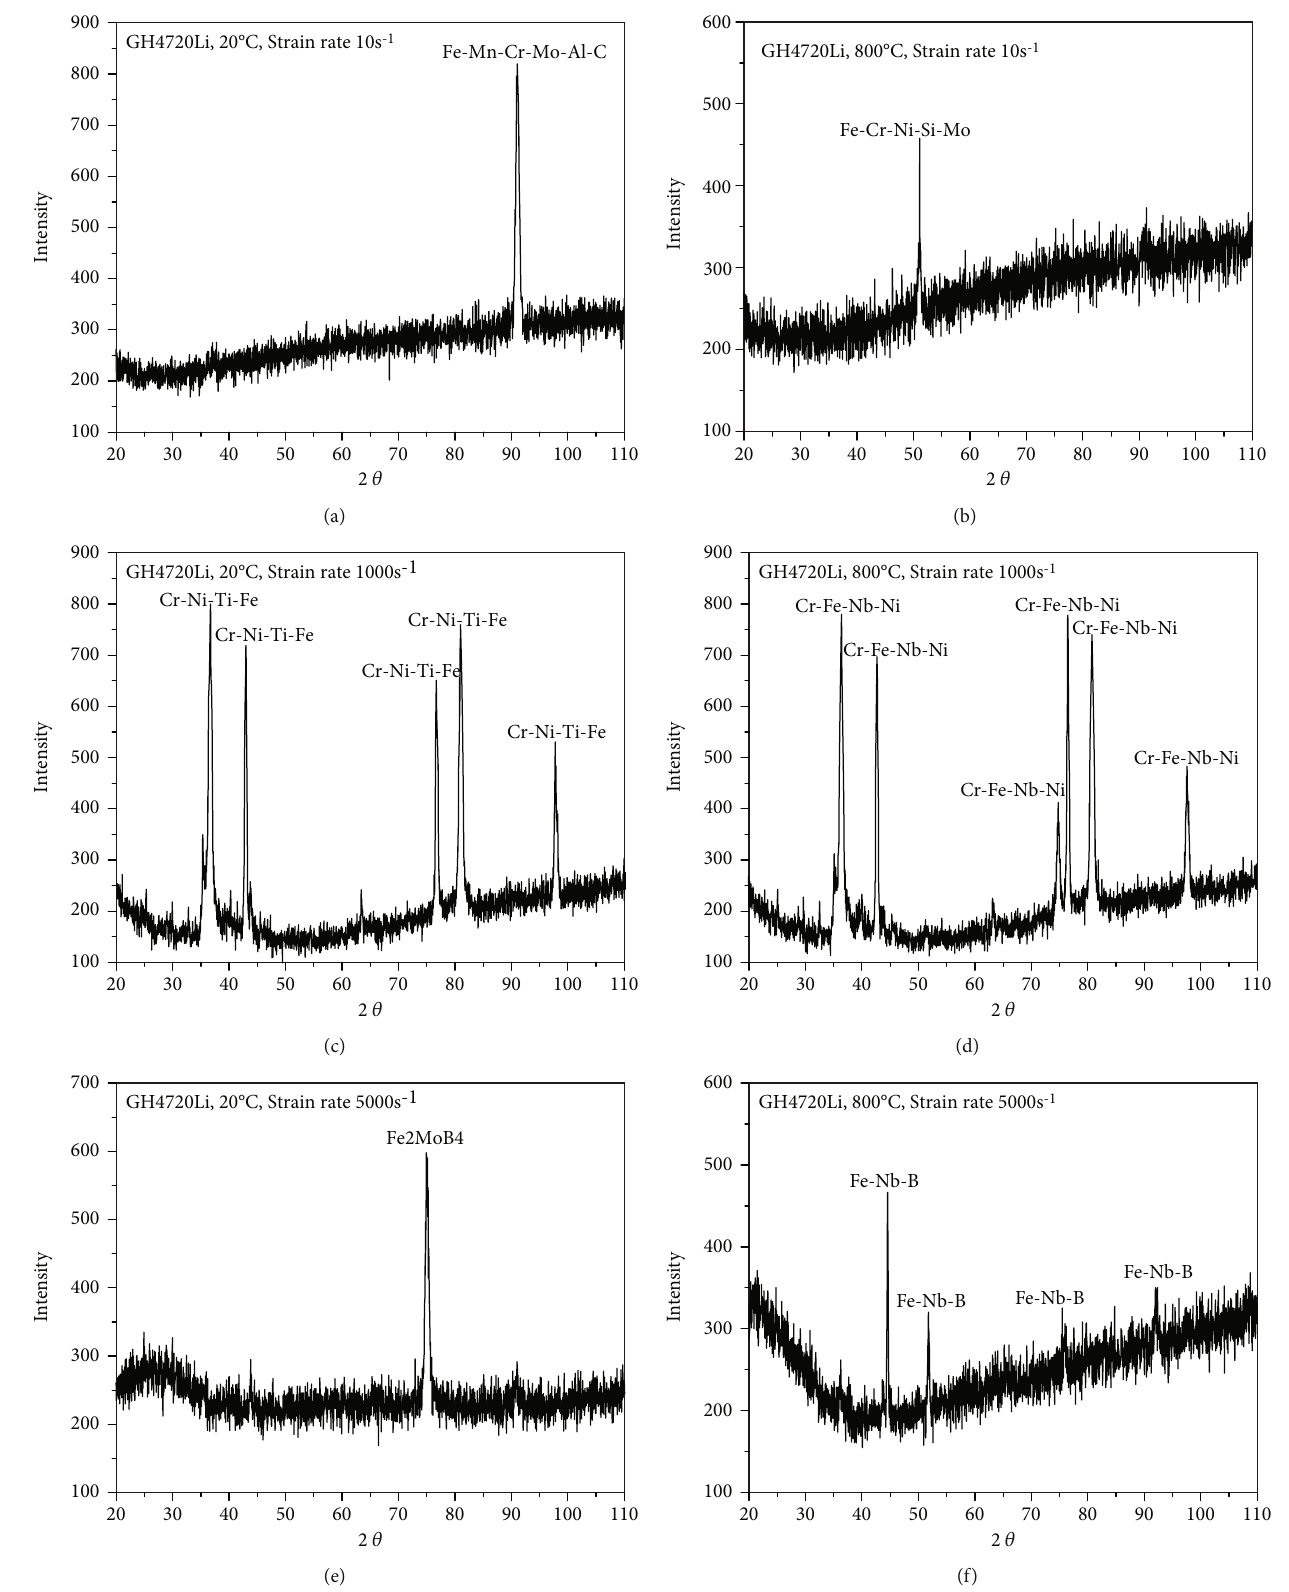
Figure 4: XRD patterns of GH4720Li superalloy under di ff erent conditions: (a) 10s -1 , 20 ° C; (b) 10 s -1 , 800 ° C; (c) 1000 s -1 , 20 ° C; (d) 1000 s -1 , 800 ° C; (e) 5000 s -1 , 20 ° C; (f) 5000s -1 , 800 °